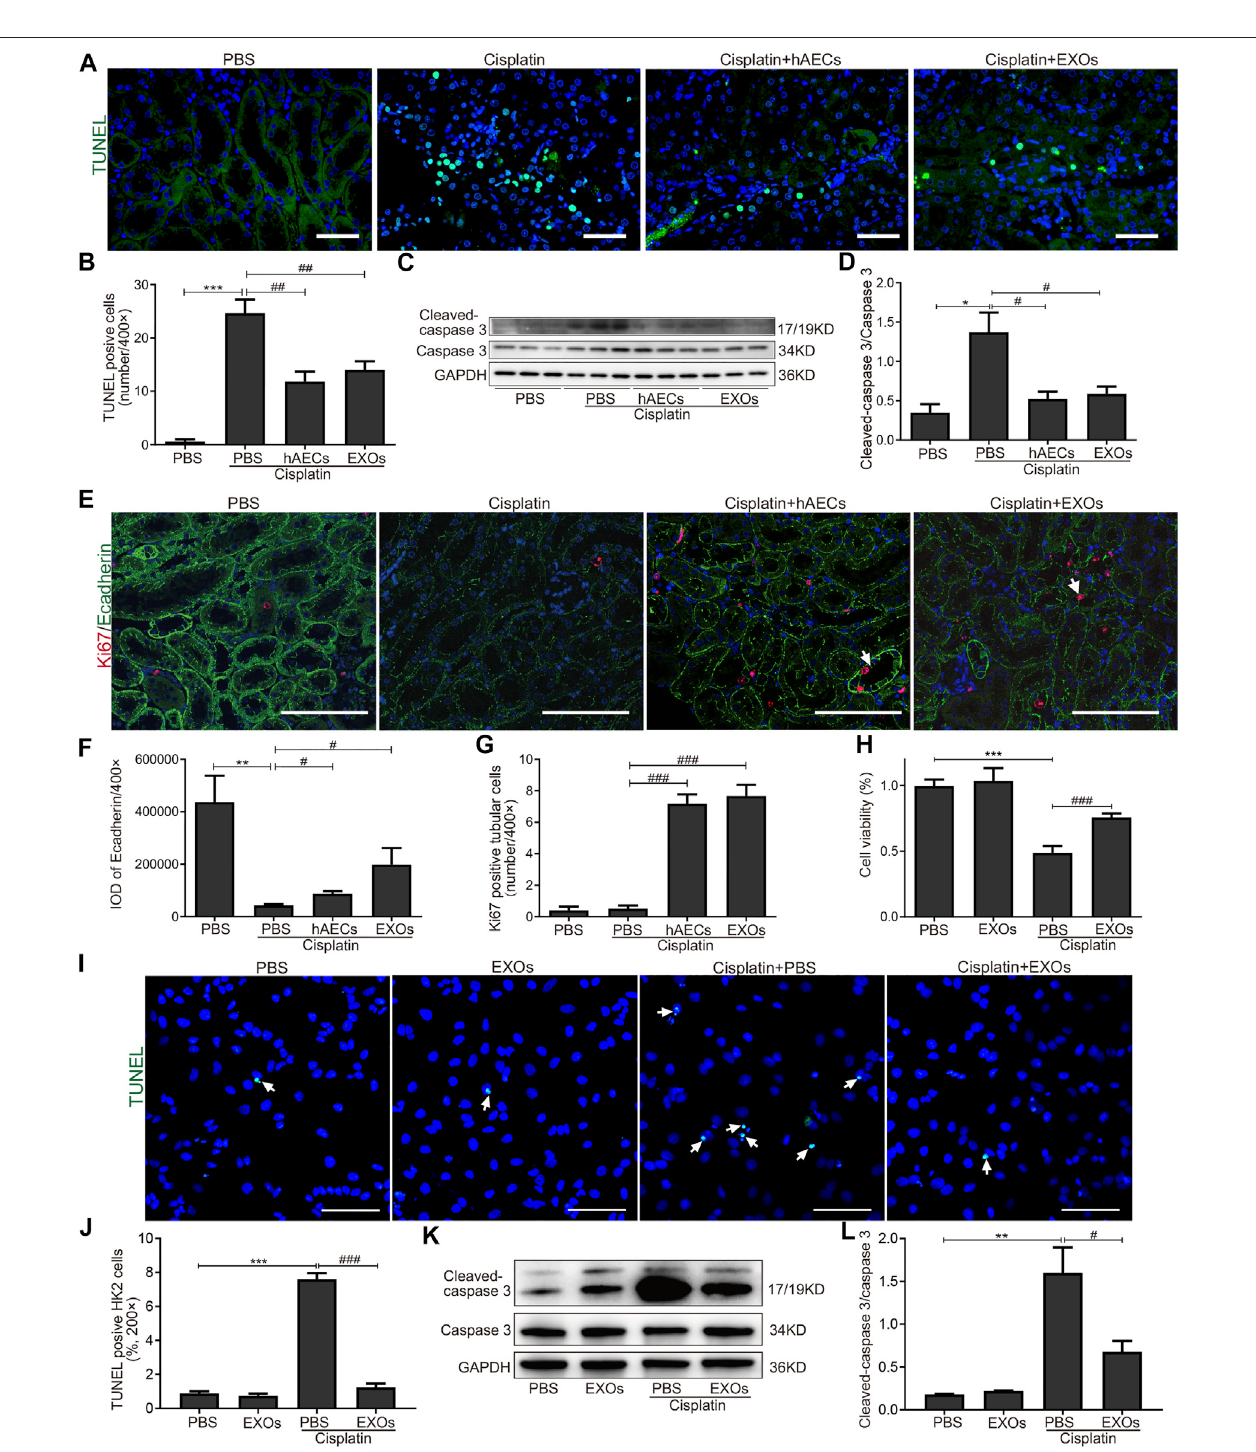
FIGURE4| Inhibitionofcisplatin-inducedapoptosisofrenaltubularepithelialcellsbyhAECsandEXOs. (A) RepresentativemicrographsofTUNEL(green)staining of kidneys from C57BL/6J mice treated with 15 mg/kg cisplatin. (B) Quanti fi cation of TUNEL-positive cells/400 × . (C) Representative Western blots showing protein expressions of cleaved-caspase 3 and caspase 3 of kidneys from C57BL/6J mice treated with 15 mg/kg cisplatin. (D) The relative protein expression of cleaved- caspase3tocaspase3indifferentgroups. n (cid:1) 3foreachgroup. (E) RepresentativemicrographsofKi67(red)andEcadherin(green)immuno fl uorescencestaining of kidneys from C57BL/6J mice treated with 15 mg/kg cisplatin. (F) Semiquantitative analysis of intensity of Ecadherin immuno fl uorescence staining. IOD, integrated optical density. (G) Quanti fi cation of Ki67-positive tubular cells/400 × . (H) CCK-8 assay showing the cell viability of HK2 cells with different treatments for 48 h. (I)